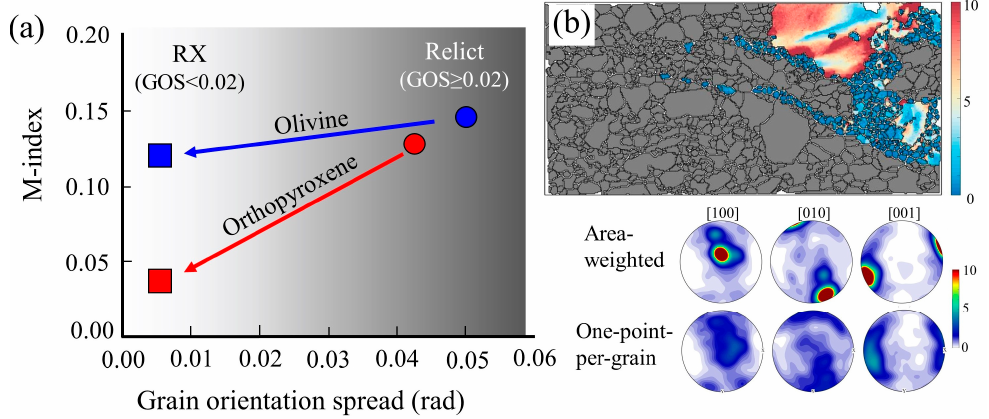
Figure 6. ( a ) Comparison of the crystallographic preferred orientation (CPO) strength for olivine and orthopyroxene (opx) porphyroclasts grains (GOS ≥ 0.02 rad) and recrystallized grains (GOS < 0.02 rad). While olivine grains show no change in the CPO strength, recrystallized opx grains show a significant reduction in CPO strength. ( b ) Opx porphyroclast grain with a characteristic tail structure of recrystallized grains depicted through its intragrain misorientations (blue to red). Olivine grains are shown in grey. Pole figures of the opx grains are shown as both area-weighted (highlighting the porphyroclast grain orientation) and one-point-per-grain (highlighting the contribution of the small recrystallized grains). Notice the dispersion of the recrystallized grains. See Figure S1 in the Supplementary Materials to see more comparisons between the olivine and opx CPO for relict and recrystallized grains and the associated EBSD maps for the data presented in panel ( a ).